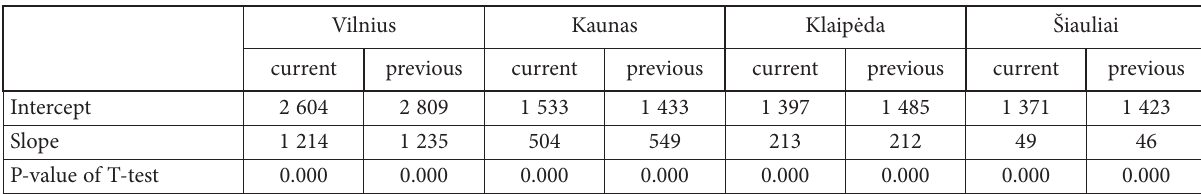
Table 6. Coefficients of a simple linear regression between the number of newcomers and housing affordability index in